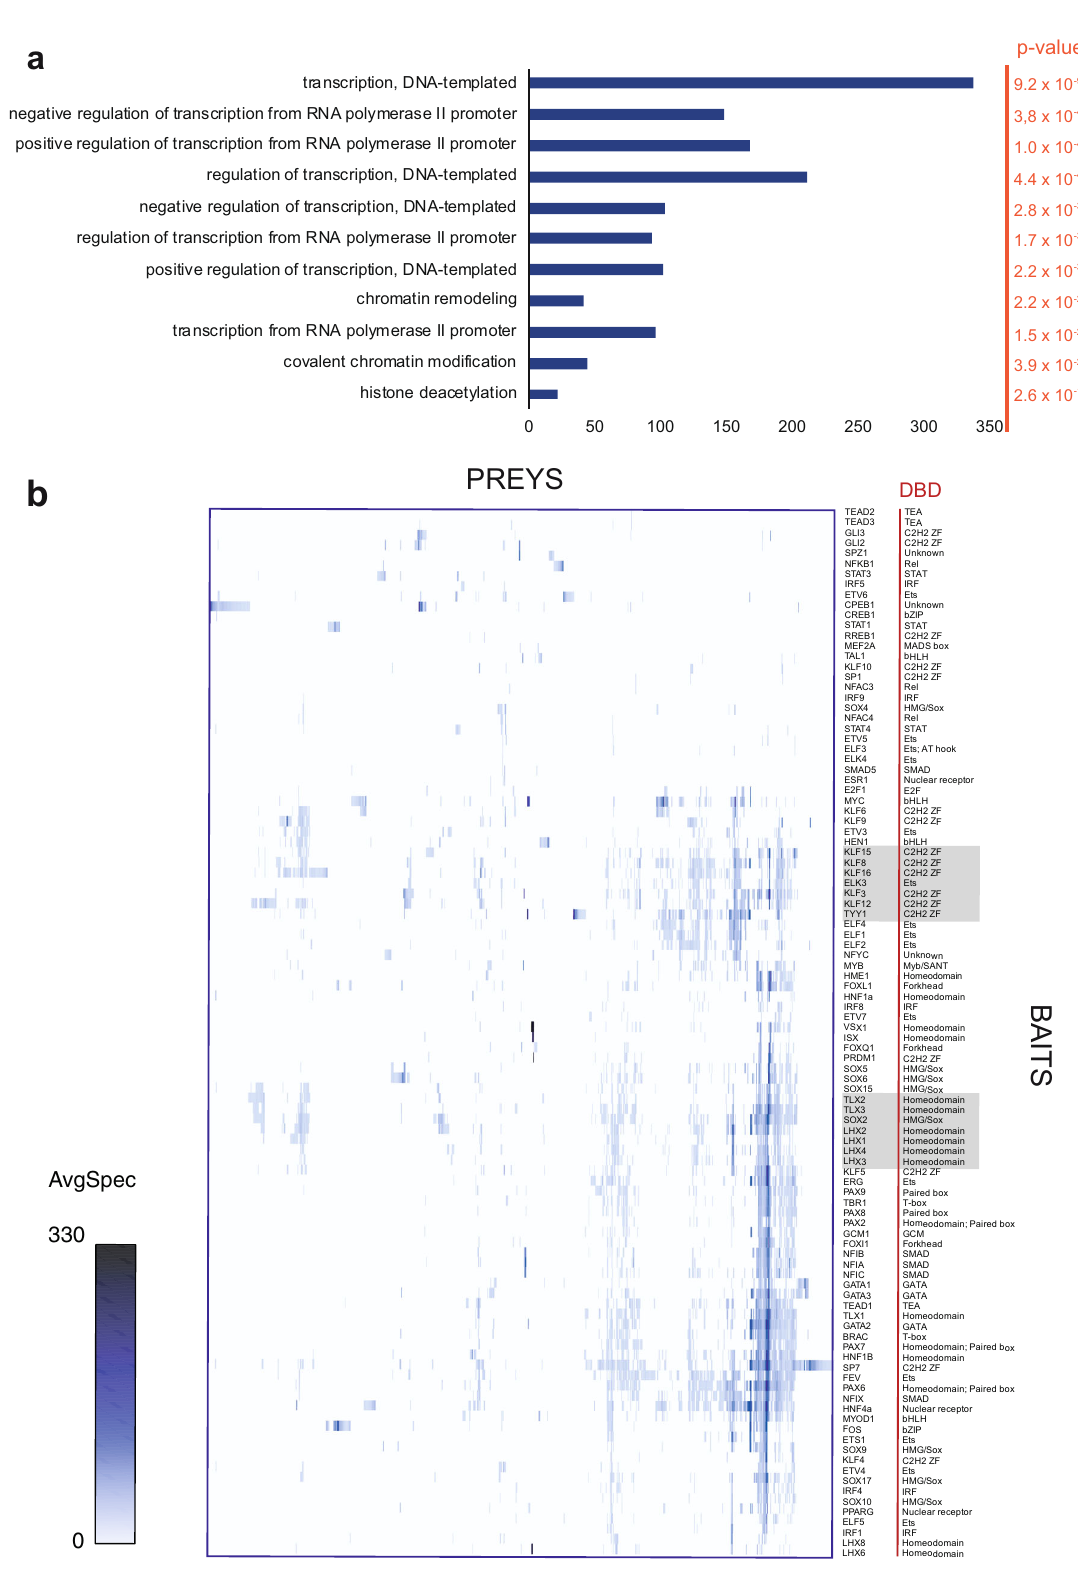
Fig. 3 Hierarchical clustering of baits by preys and its correlations to DNA-binding domains of studied TFs. a Enriched Gene Ontology Biological Processes of the high-con fi dence interacting proteins from the BioID analysis indicate high enrichment of DNA-templated transcription regulating proteins and chromatin modi fi ers as TF interactors. b The TF bait proteins and their interacting prey proteins from BioID analysis were hierarchically clustered (ProHits-viz.) and visualized in the heatmap (note that the color gradient shows the interaction abundancy (spectral counts) value for the prey). Source data of the fi gure are provided as a Source Data fi